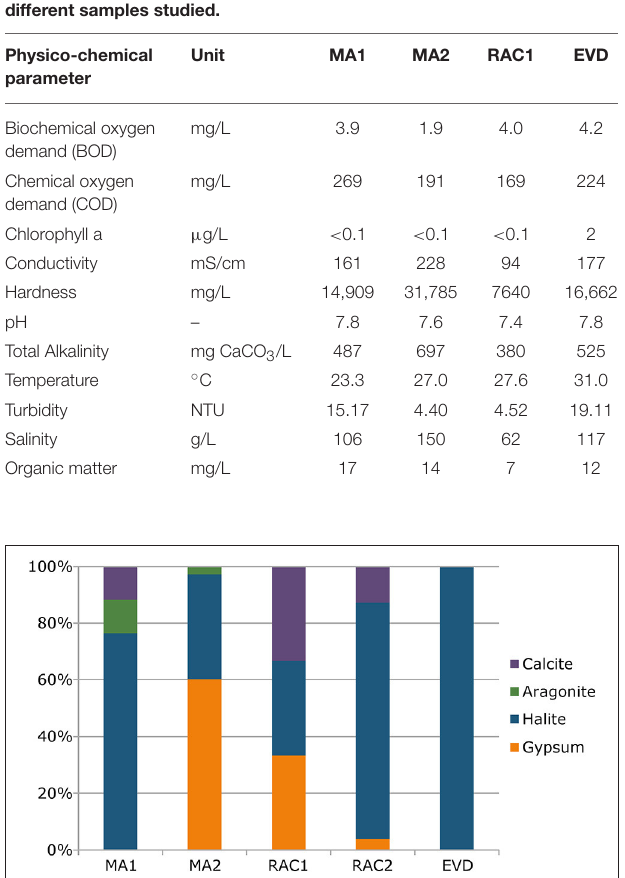
FIGURE 2 | Mineral composition of microbial mats (MA1 and MA2), rhizome-associated lithified concretions (RAC1 and RAC2), and evaporite (EVD) obtained by X-ray diffraction (XRD)